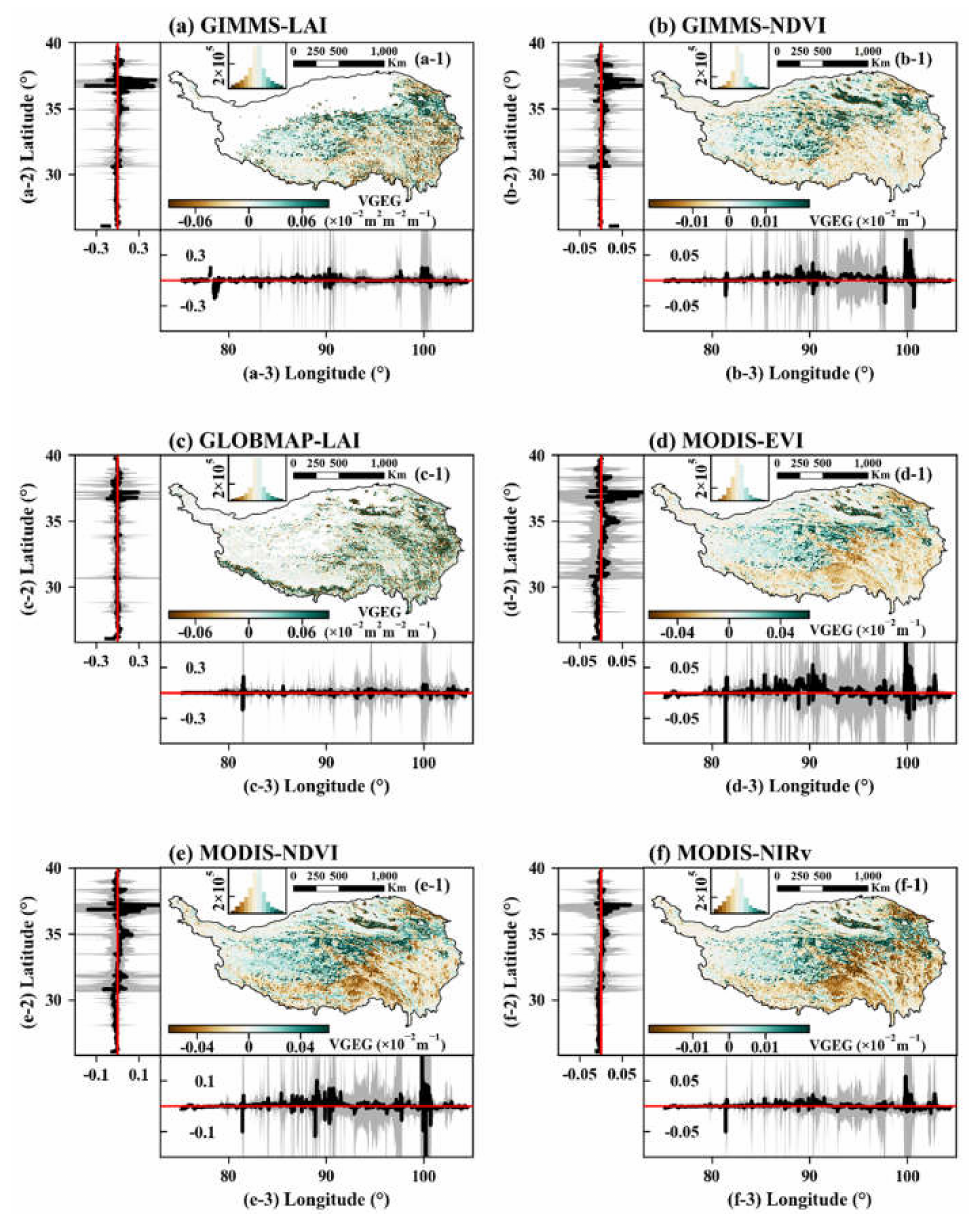
Figure 7. Spatial pattern of the mean VGEG from 2001 to 2016 ( a-1 – f-1 ). The value frequency inset is in the upper-left of each main figure. The subfigures ( e-2 – f-2 ) and ( e-3 – f-3 ) denote the latitudinal and longitudinal distributions of VGEG; the shadow regions represent one standard